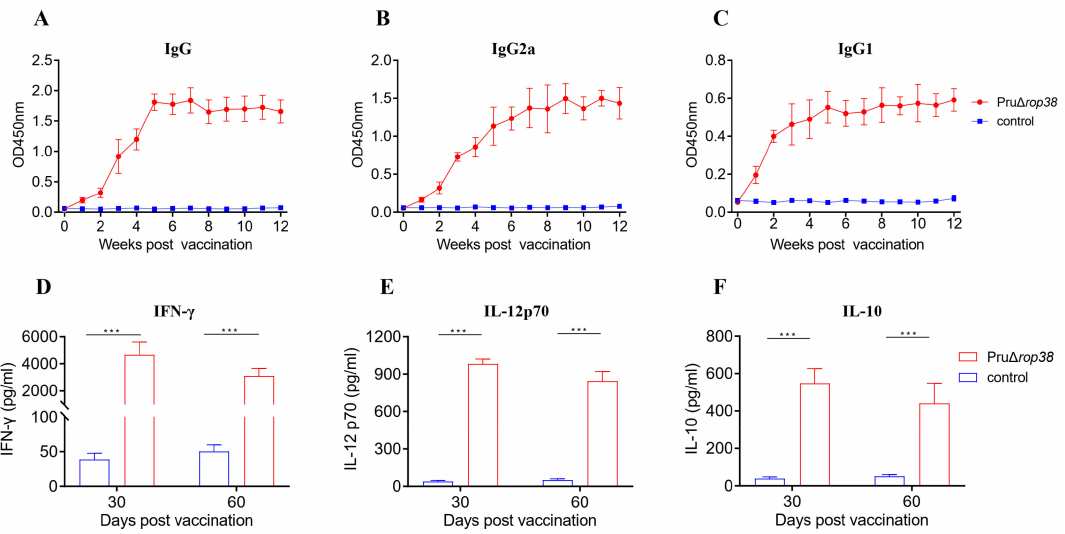
Figure 3. Humoral and cellular immune responses induced by Pru ∆ rop38 . Levels of IgG and its subtype (IgG2a and IgG1) antibodies in the serum obtained from vaccinated and control mice. ( A ) IgG, ( B ) IgG2a, and ( C ) IgG1, respectively ( n = 3; weekly serum collection after immunization). The levels of cytokines in the suspension of splenocyte in vaccinated and control mice. Splenocytes were collected at 30 or 60 days post-vaccination and co-incubated with TSA (50 µ g/mL), and the levels of ( D ) IFN- γ , ( E ) IL-12, and ( F ) IL-10 were analyzed by ELISA ( n = 3; presented as the mean ± SD; *** p < 0.001; Student’s t